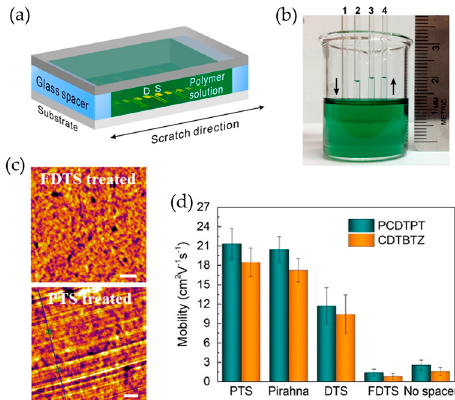
Figure 10. ( a ) Schematic illustration of the sandwich tunnel system consisting of two silicon substrates with a pair of glass spacers inserted at two ends. D and S denote the bottom-contact drain and source electrode, respectively. ( b ) Capillary height tests on polymer solution prepared in chlorobenzene using glass capillary tubes (inner diameter: ca. 1.2 mm) with various surface treatments: (1) perfluorodecyltrichlorosilane (FDTS); (2) n-decyltrichlorosilane (DTS); (3) piranha solution; (4) 6-phenylhexyltrichlorosilane (PTS); and ( c ) AFM images of the bottom surfaces of two deposited films approaching FDTS-treated spacer (top) and PTS-treated spacer (bottom). Scale bars represent 200 nm. ( d ) Comparison of the average saturation mobility of the devices prepared from poly[4-(4,4-dihexadecyl-4 H -cyclopenta[1,2-b:5,4-b ′ ]dithiophen-2-yl)- alt -[1,2,5] thiadiazolo[3,4-c]pyridine] (PCDTPT) and poly[2,6-(4,4- bis -alkyl-4 H -cyclopenta-[2,1-b;3,4-b0]-dithiophene)- alt -4,7-(2,1,3-enzothiadiazole)] (CDTBTZ) with various surface treatments over the pair of spacers.